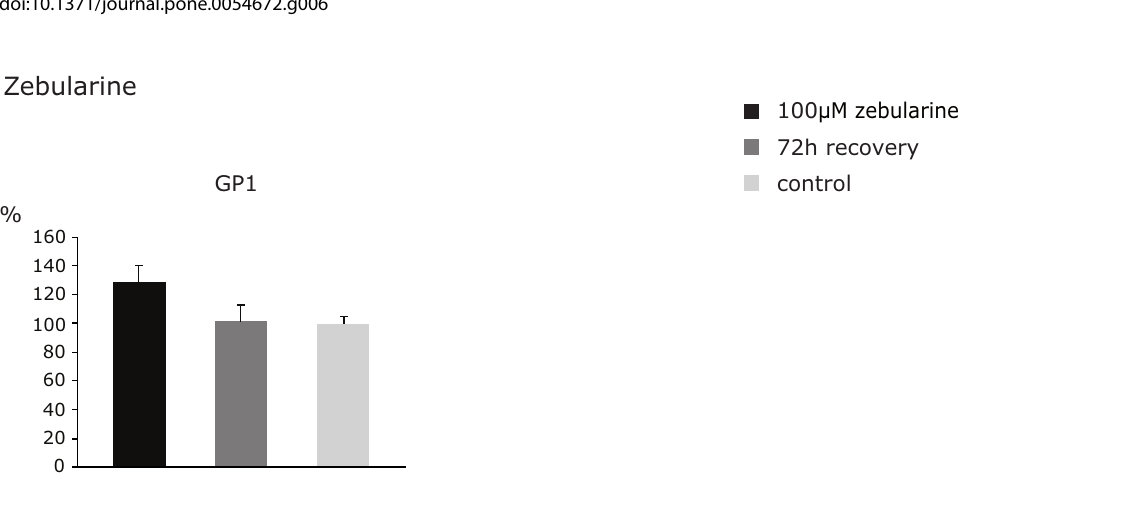
Figure 6. Changes in mean contributions of glycan groups GP1, GP5 and GP7 following Na-butyrate treatment and recovery. The observed changes were normalized to control values, which were set to 100%. The error bars represent standard deviations obtained on the basis of 3 independent experiments.